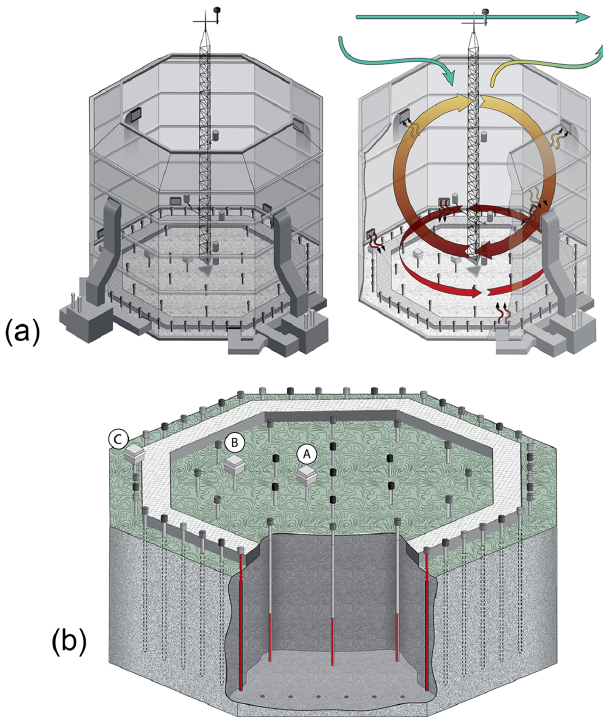
Figure 2. (a) Diagram of the air-warming enclosure, warm air flow pattern and external wind inputs leading to a homogenized air en- velope that surrounds the aboveground vegetation. (b) Diagram of the belowground heater distribution pattern and the functional heating surfaces. The 100W heaters are deployed in an inner sec- tion A (seven deep only heaters), middle section B (12 deep only heaters) and outer section C (three alternating circuits of 48 full- length